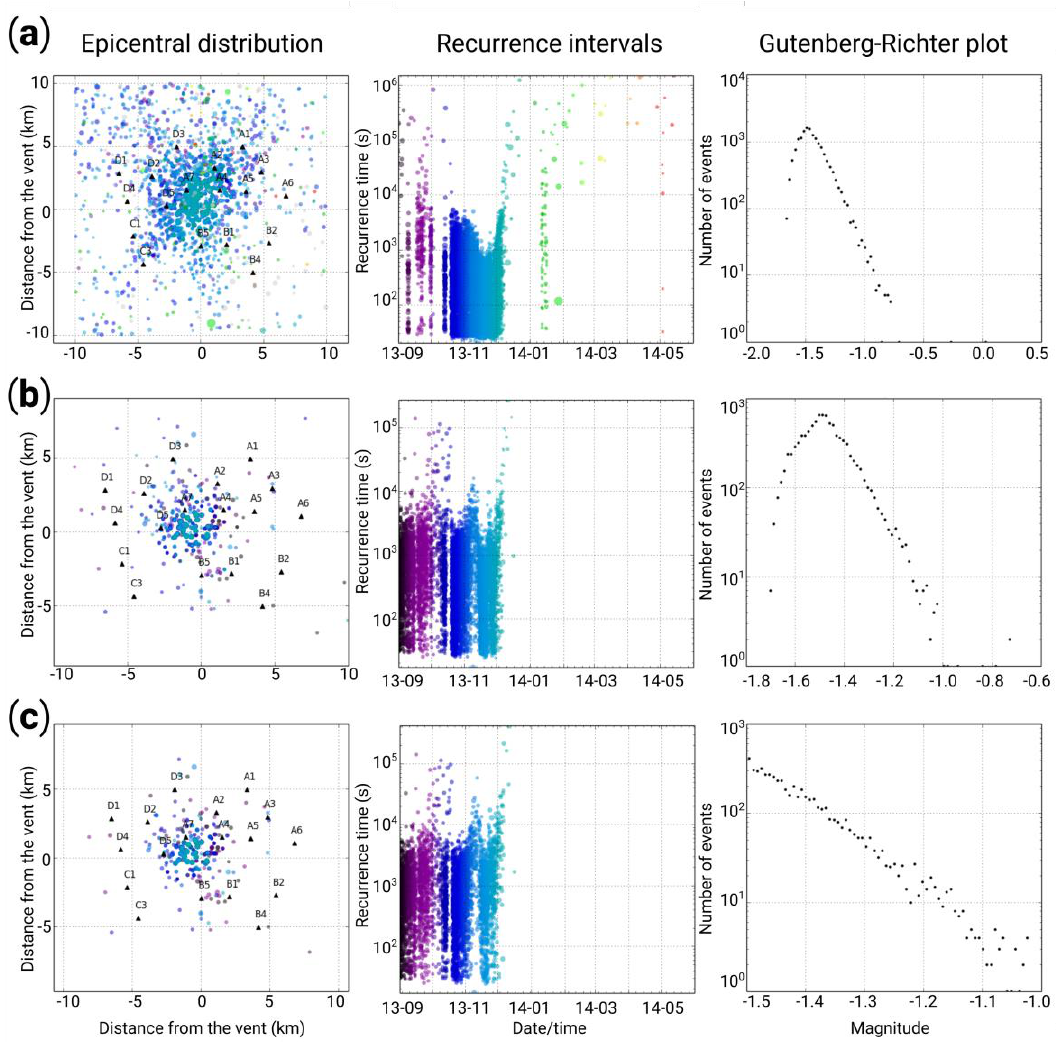
Figure 5. Results of applying the BP detection algorithm to Gorely data: ( a ) detections acquired using records of five temporary stations which functioned nine months; ( b ) same for 18 stations working during the four starting months, when degassing activity was exceptionally strong; ( c ) filtered detections obtained with 18 stations, which follow Gutenberg–Richter law and constitute BP-based catalog.